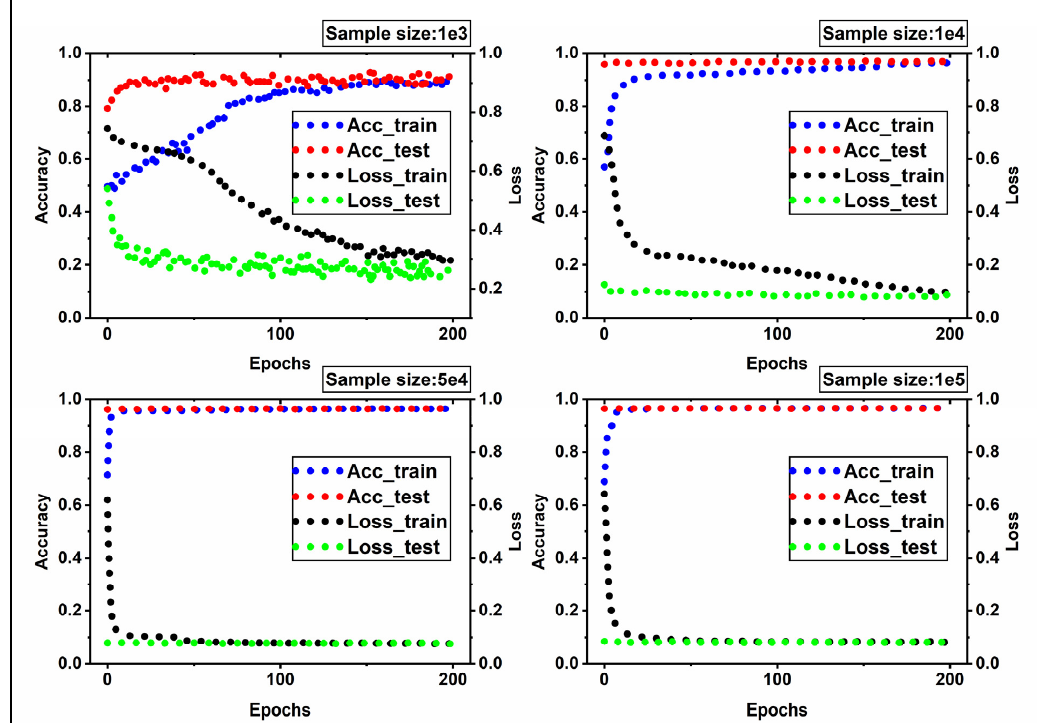
Figure 9. The graphs demonstrate the trend of accuracy and loss function for the train and test datasets. The accuracy combined with the cross-entropy function can monitor the progress of NN convergence for classification. The blue and red circles depict the accuracy profile for train and test data sets, respectively, while the black and green circles depict the loss function profile for train and test data sets.